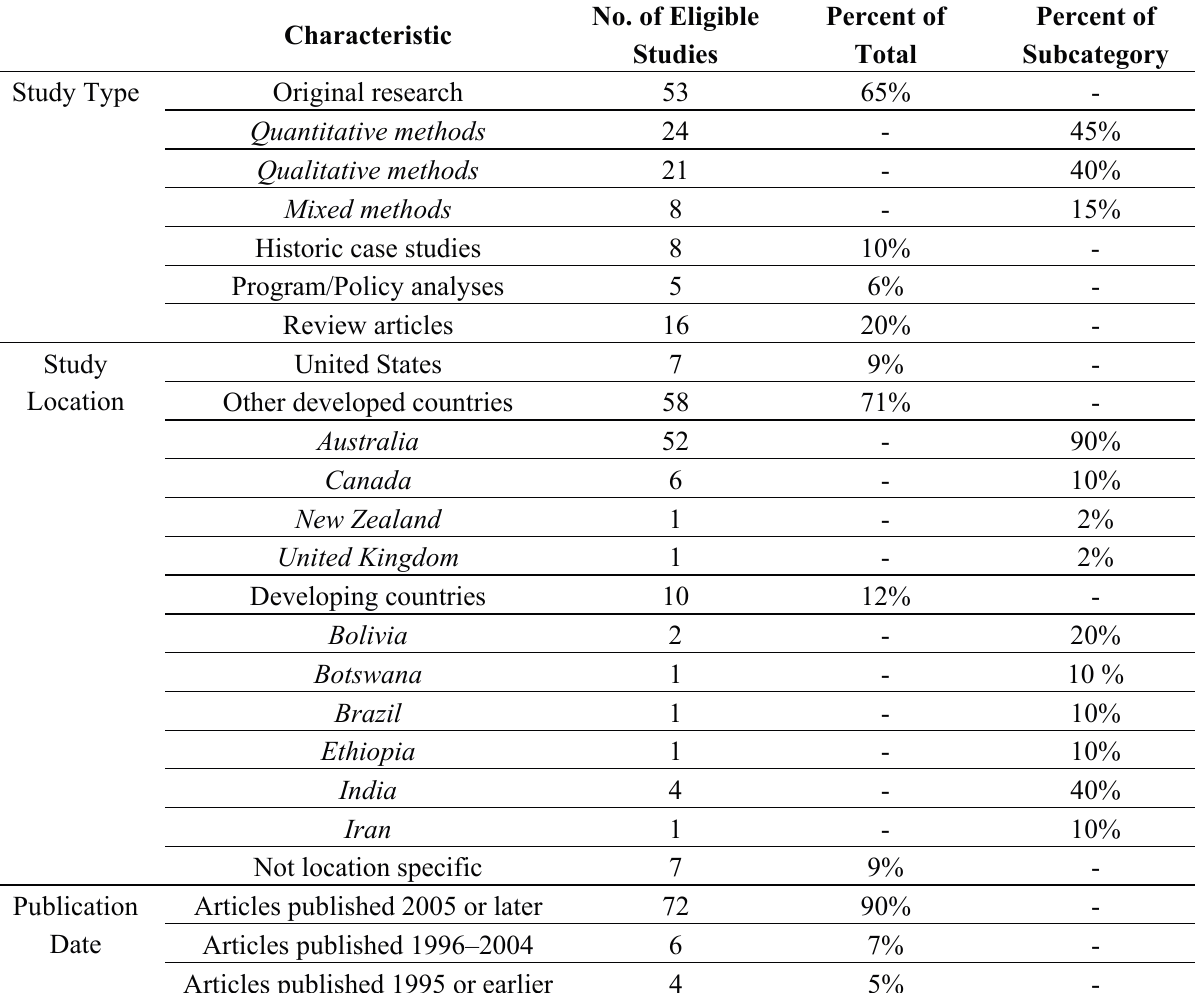
Table 1. Summary of Characteristics of Included